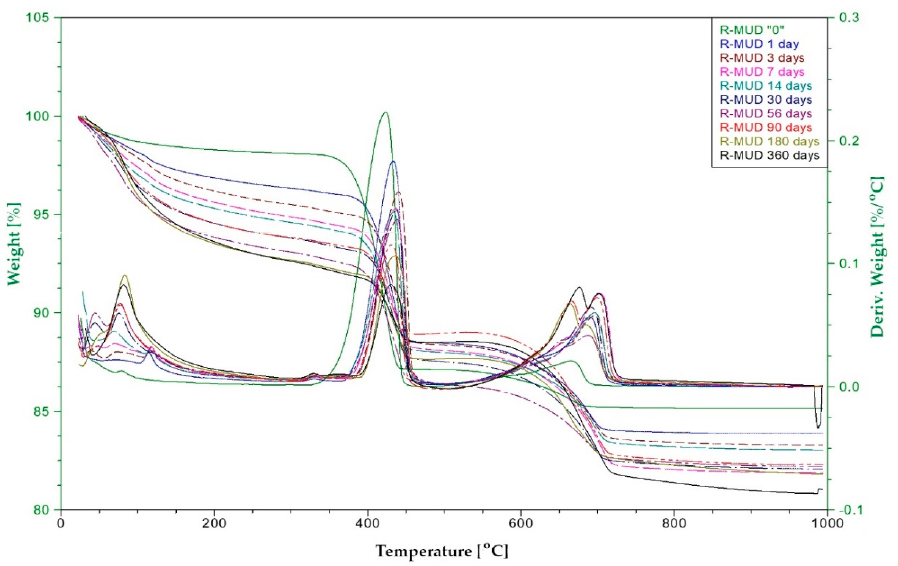
/ Ca(OH) ff erent periods of 2 samples after di